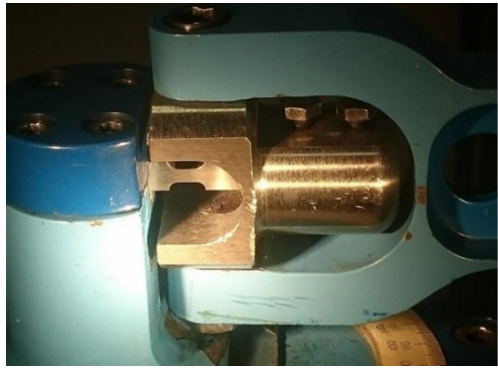
Figure 3. Clamped specimen in MZGS-100